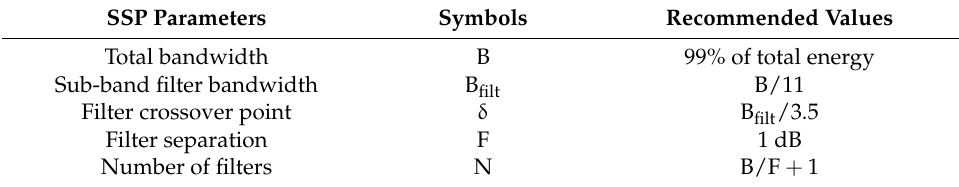
Table 1. Recommended values for SSP